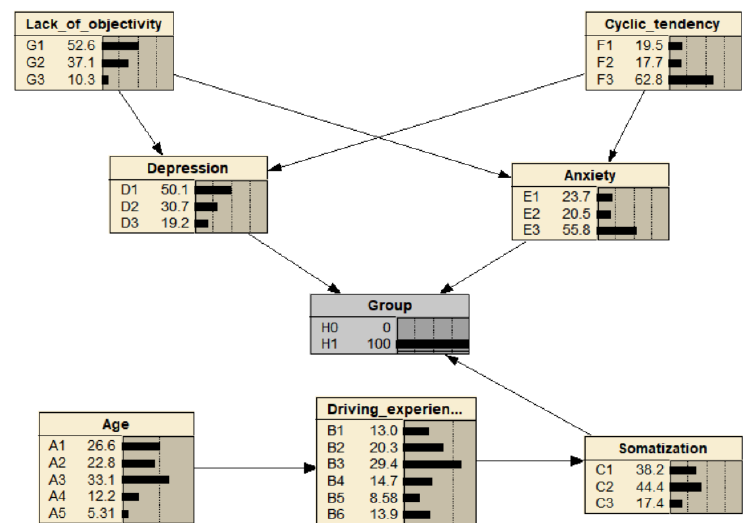
Figure 7. Evidence variable as the diagnosis of accident